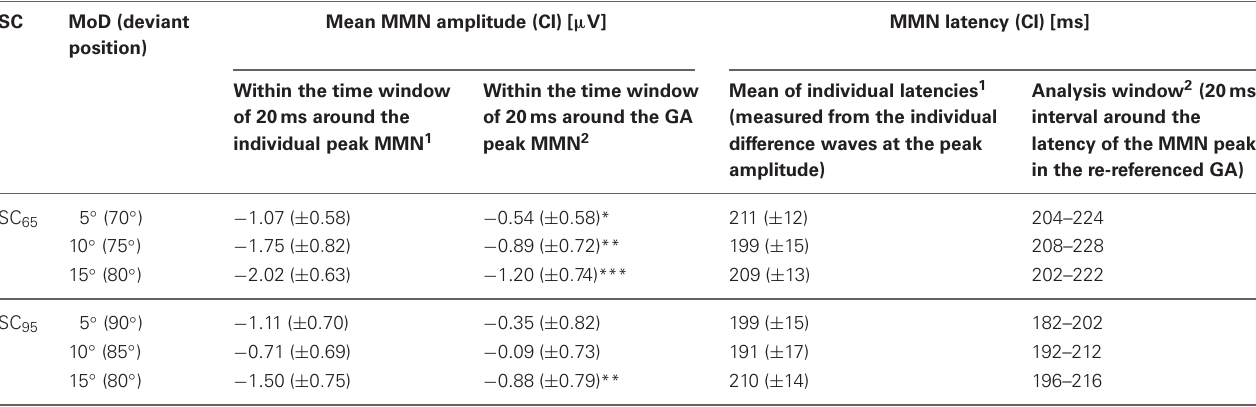
FIGURE 3 | Re-referenced difference waveforms. Averaged difference waveforms (solid lines) at Fz re-referenced to mean ERP signal obtained at mastoid electrodes (dotted gray line). Left : deviations within the mid-lateral space (SC 65 ) Right : deviations within the far-lateral space (SC 95 ). The Magnitude of Deviation (MoD) relative to standard position is color-coded: blue ± 5 ◦ , orange ± 10 ◦ , green Table 1 | Mismatch negativity